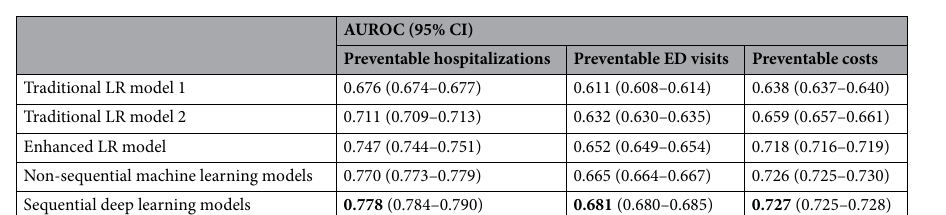
Table 3. Discriminative performance comparison of alternative traditional and enhanced risk prediction models for the prediction of preventable hospitalizations, preventable emergency department visits, and preventable costs among heart failure patients. AUROC, Area Under the Receiver Operating Characteristic; CI, Confidence Interval; LR, Logistic Regression.